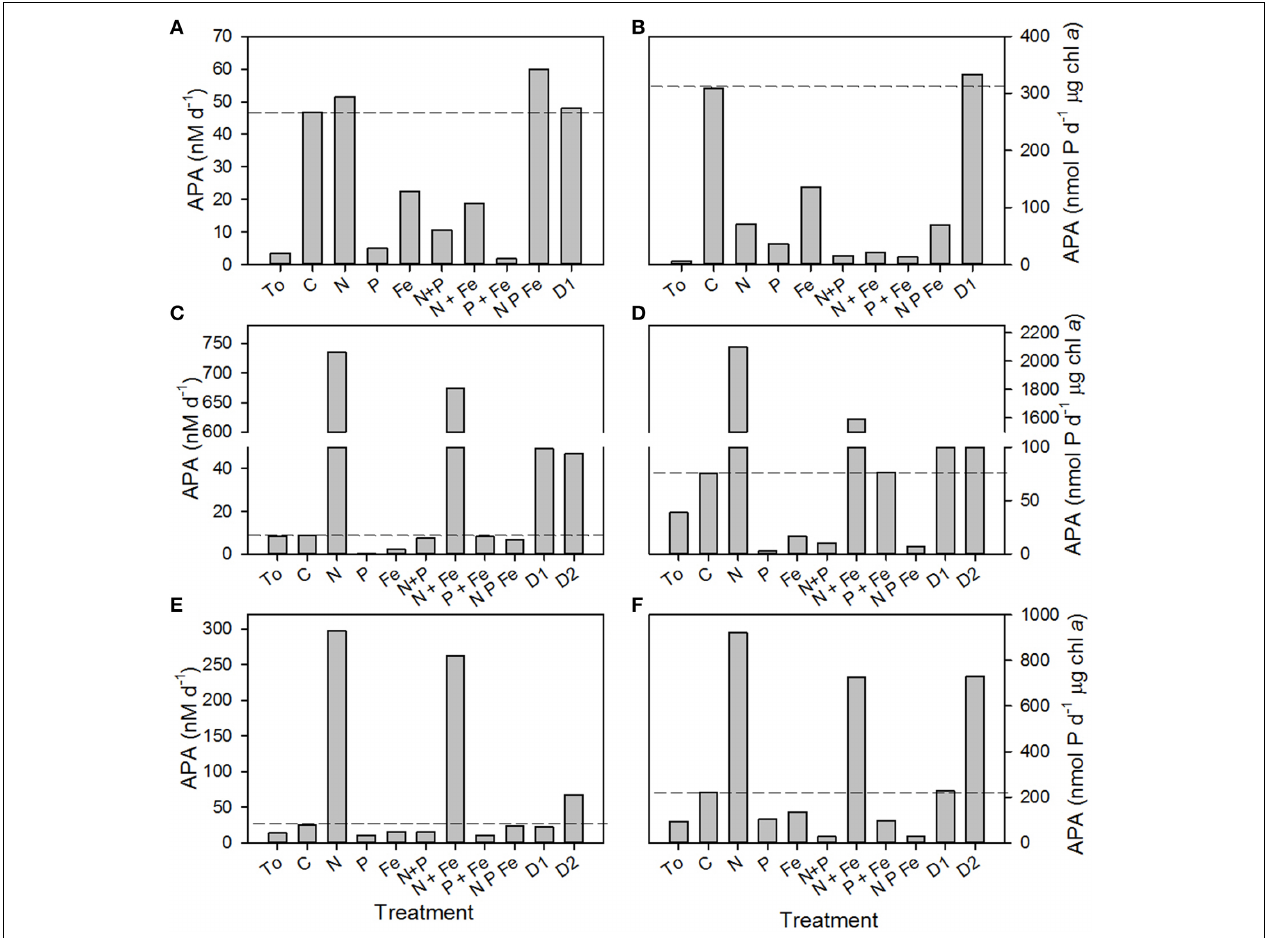
FIGURE 3 | Volumetric rates (nM d − 1 , A,C,E) and chlorophyll a normalized rates (nmol P d − 1 µ g chl a , B D,F) of alkaline phosphatase activity (APA) in response to the addition of nitrogen (N 1 µ M of ammonium plus 1 µ M of nitrate), phosphate (P, 0.2 µ M), iron (Fe, 2nM of iron in dilute hydrochloric acid), a combination of 2 or 3 nutrients,